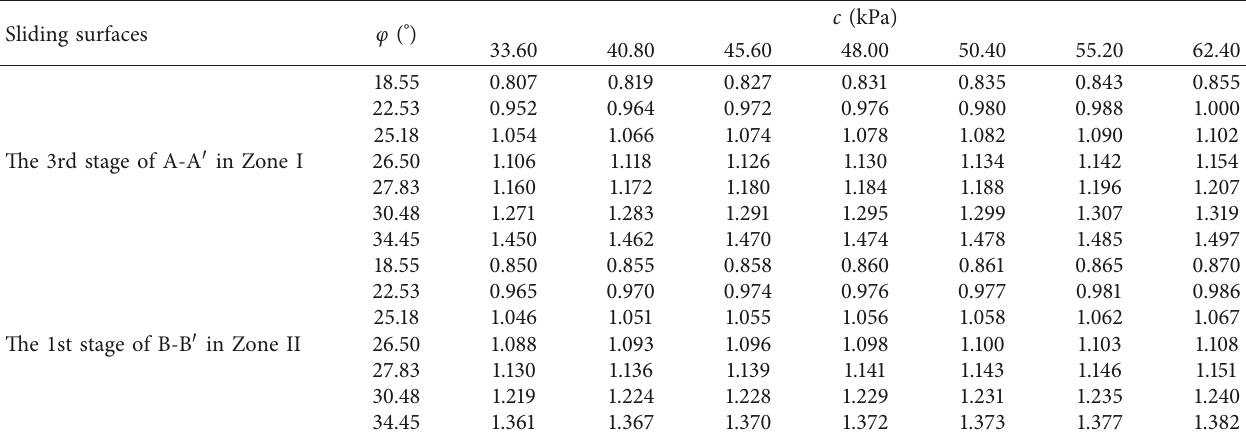
Table 3: Factors of safety for different landslide stages in Zone I and Zone